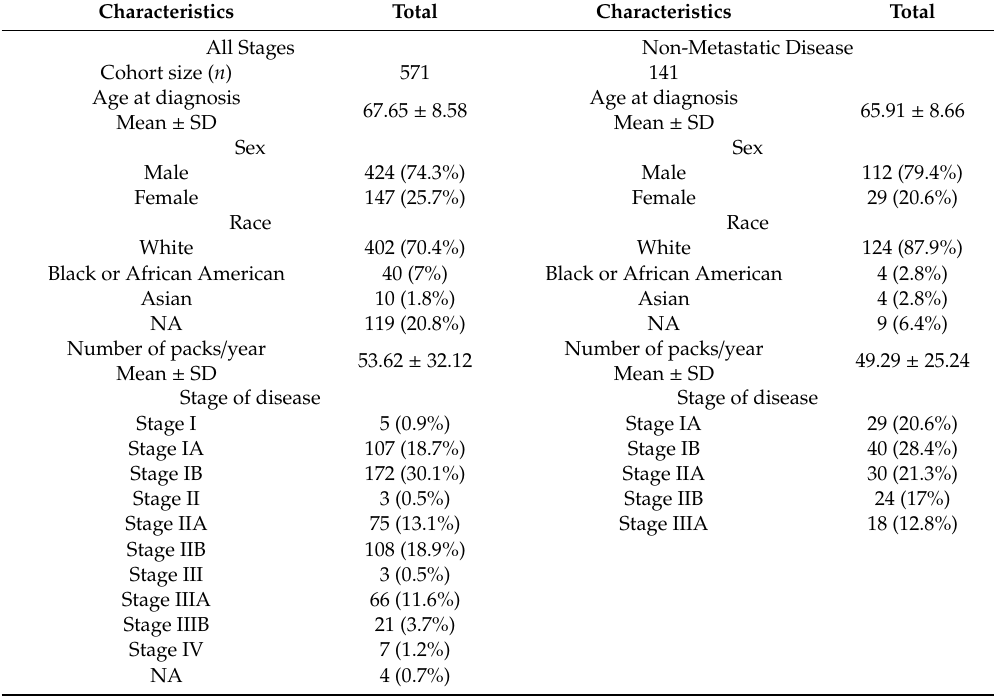
Table 3. Clinical-pathological data of lung squamous cell carcinoma (LUSC) from the TCGA